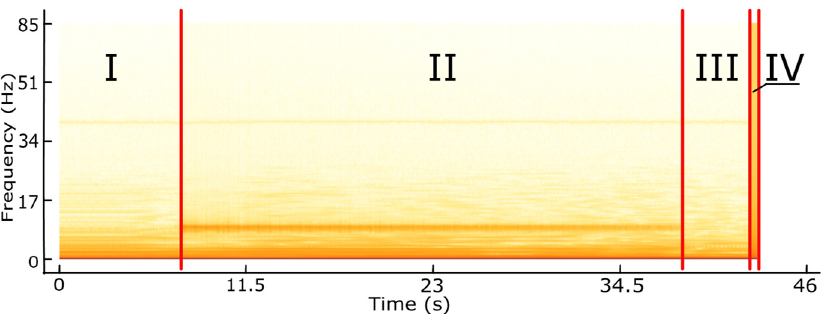
Figure 4. Amplitude spectrum spectrogram for each t moment of the recorded displacement signal based on the graph in Figure 3.